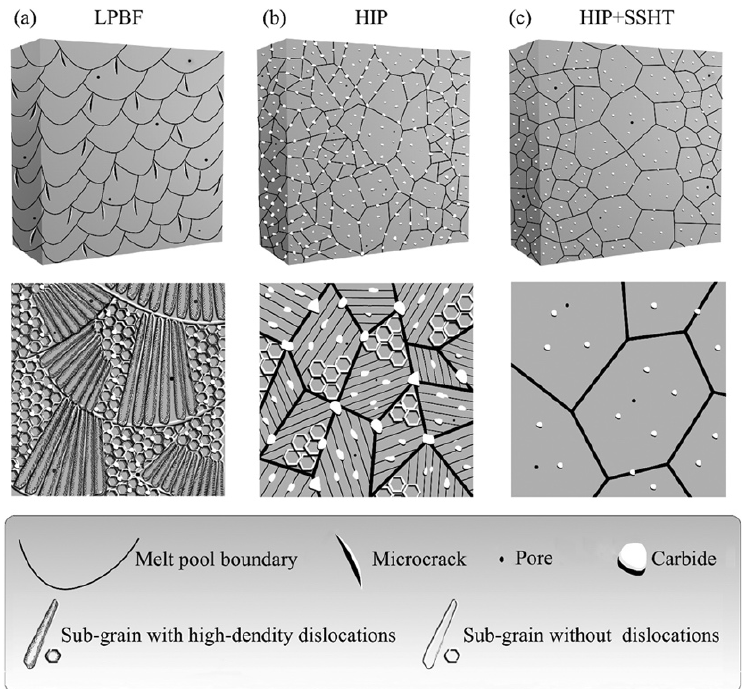
Figure 21. Microstructure development schematic of the LPBF GH3536 sample subjected to the HIP and SSHT. ( a ) The as-built state after L-PBF process. ( b ) After HIP treatment. ( c ) After SSHT treatment [62] .